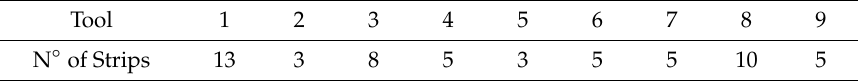
Table 3. Number of Magnesium AZ31 Strips Tested for Each